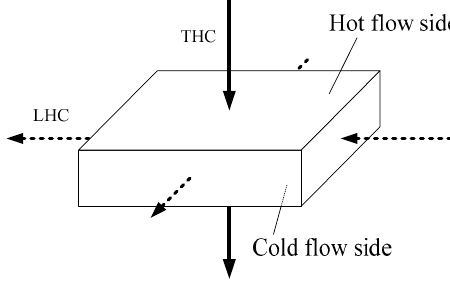
Figure 2. Actual heat transfer in plate.